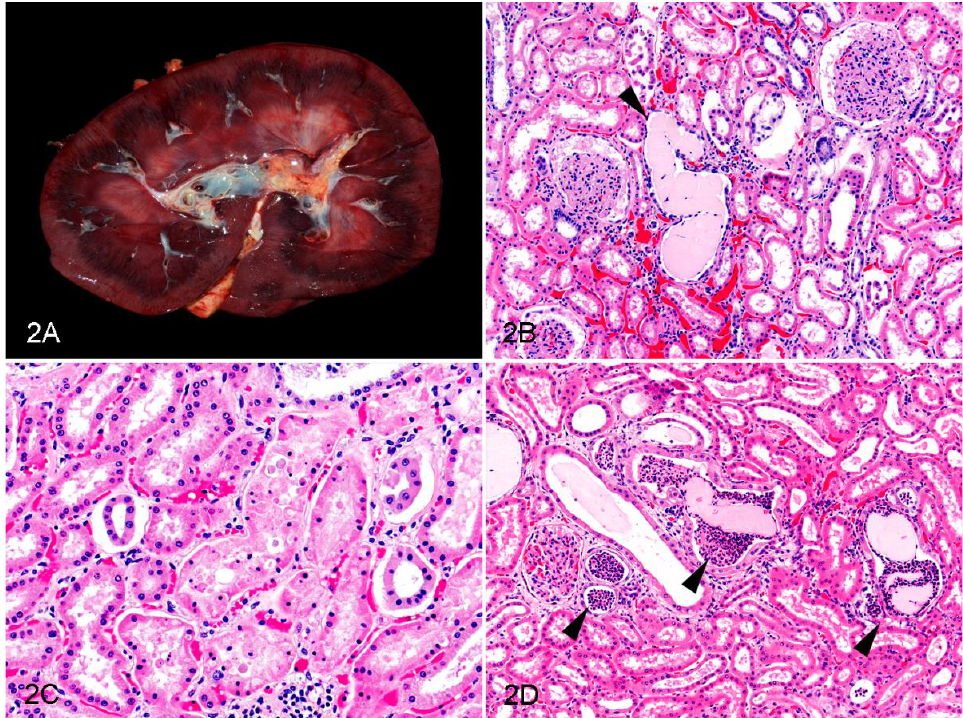
Figure 2. Renal lesions in horses with oleander poisoning. ( A ) Gross aspect of the kidney, showing marked corticomedullary congestion; Case 20. ( B – D ) Microscopic changes in the renal cortex (Hematoxylin and eosin). ( B ) Dilated tubule with a hyaline cast and attenuated epithelium (arrowhead); Case 15. ( C ) Tubular epithelial necrosis with hypereosinophilia, cellular fragmentation, and pyknosis; Case 20. ( D ) Neutrophilic casts within the tubular lumina (arrowheads). Some hyaline casts are mixed with the neutrophilic aggregates; Case 8. Table 2. Histological findings in the kidneys of horses with oleander poisoning and control horses.